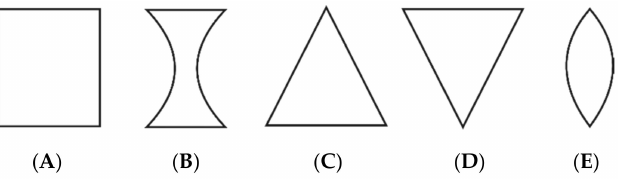
Figure 2. Classification of glottal closure types: ( A ) rectangle/longitudinal, ( B ) hourglass, ( C ) triangle, ( D ) V-shaped, ( E )